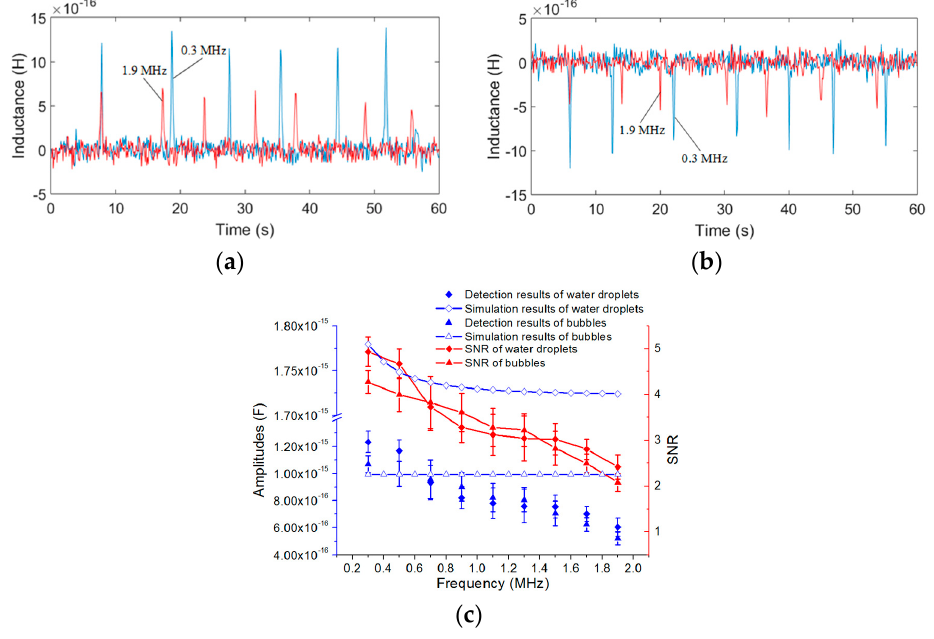
Figure 9. Capacitance detection results and theoretical capacitance changes at different excitation frequencies (each coil has 20 turns): ( a ) detection results of water droplets with sizes ranging from 210 to 220 μ m, excitation frequency of the red line was 1.9 MHz; excitation frequency of the blue line was 0.3 MHz; ( b ) detection results of bubbles with sizes ranging from 280 to 300 μ m, excitation frequency of the red line was 1.9 MHz; excitation frequency of the blue line was 0.3 MHz; ( c ) comparison between the experimental results and the analytical predictions at different excitation frequencies, the conductivity of water droplet, bubble and oil were 1 × 10 − 4 S/m, 0 S/m and 8 × 10 − 10 S/m, respectively.